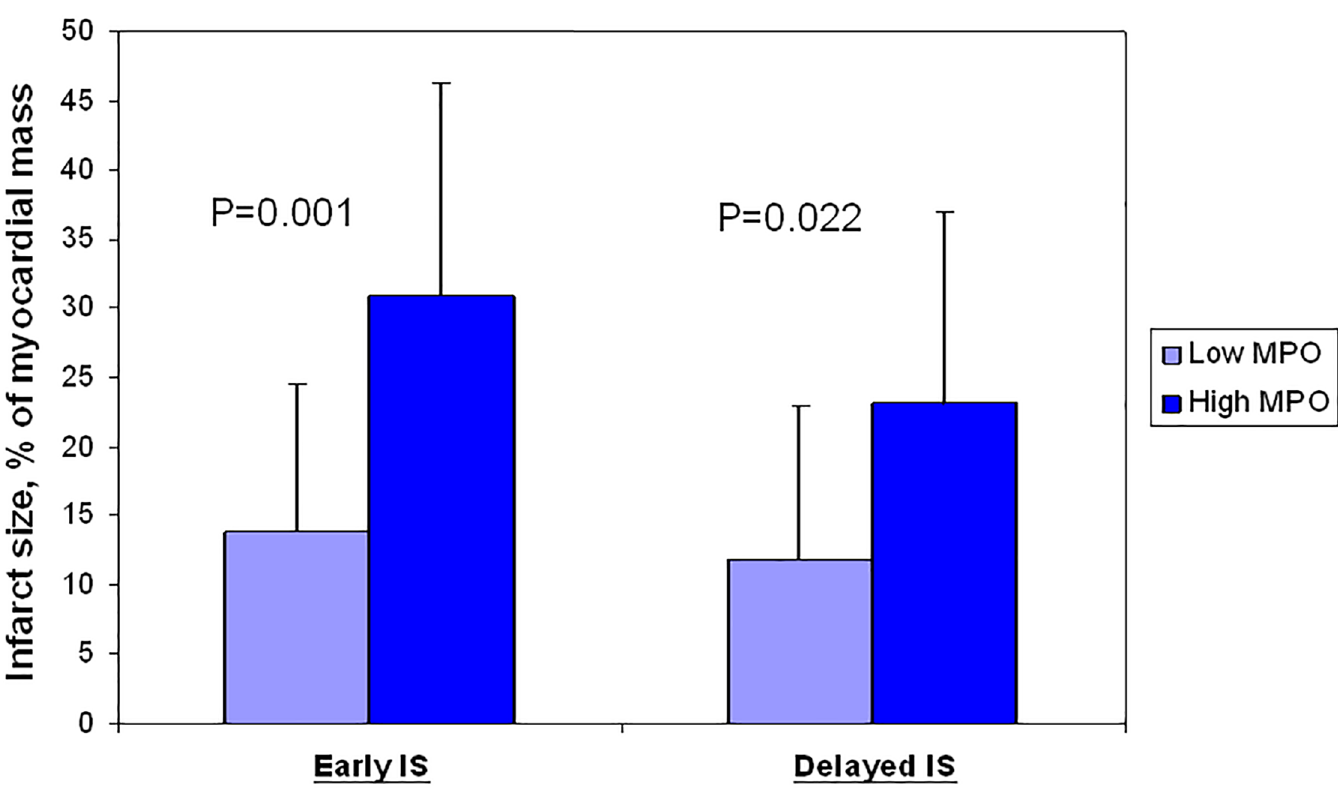
Fig 1. Infarct size regarding MPO plasma levels in the culprit artery assessed by CMR at day 3 and 6 months.